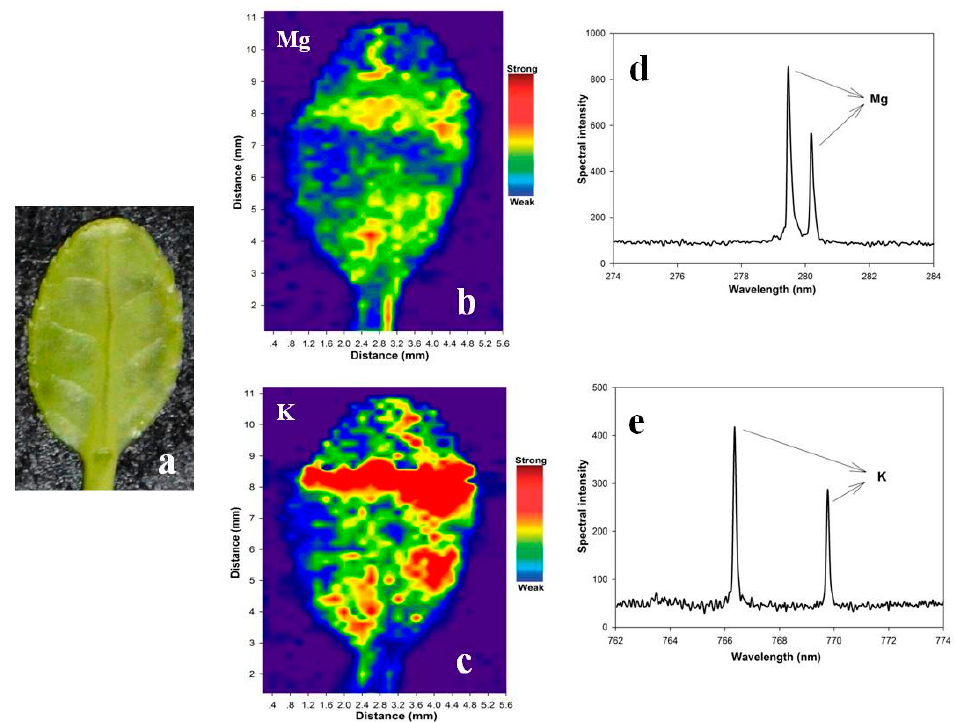
Figure 3. The mapping results of holly (Ilex chinensis Sims) leaf based on the spectral intensities of specific elements using LipsImag. ( a ) The visible image of the leaf for the mapping experiment; ( b ) and ( c ) shows the distributions of the spectral intensities of Mg and K, respectively; ( d , e ) illustrate the spectral characteristics of Mg and K that were used for